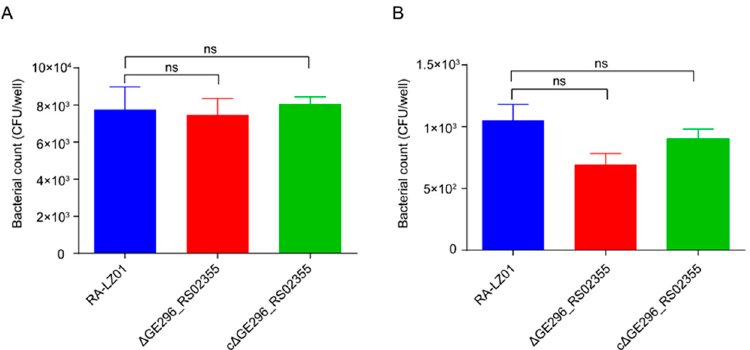
Figure 6. Bacterial adherence and invasion assays. ( A ) Adherence assay. ( B ) Invasion assay. Strains RA-LZ01, RA-LZ01 Δ ranQ , and RA-LZ01c Δ RanQ were tested on Strains RA-LZ01, RA-LZ01 ∆ RanQ , and RA-LZ01c Δ RanQ using duck brain microvascular endothelial cells. The data indicate the number of bacteria adherence to or invasion of duck brain microvascular endothelial cells per well in 48-well plates. The standard deviation is calculated from three independent experiments and expressed by error lines. (ns, p > 0.05).